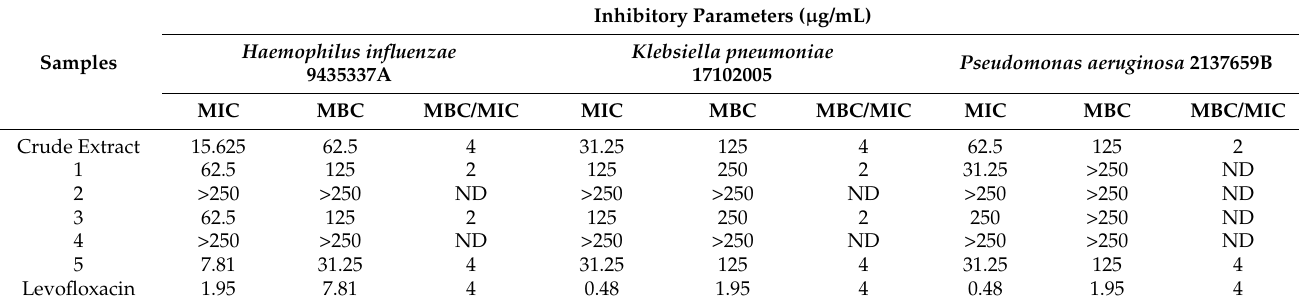
Table 2. Average inhibitory and bactericidal concentrations (MIC and MBC) of the crude extract and compounds 1 – 5